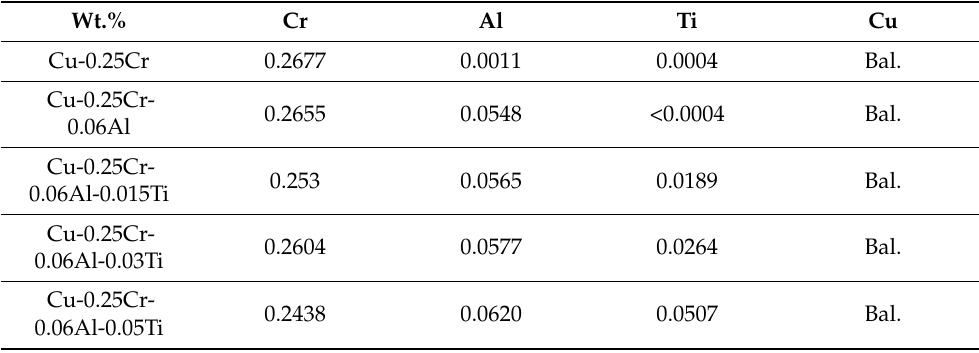
Table 1. List of chemical compositions of Cu-Cr alloys by using spectrometer. Wt.% Cr Al Ti Cu Cu-0.25Cr 0.2677 0.0011 0.0004 Cu-0.25Cr-